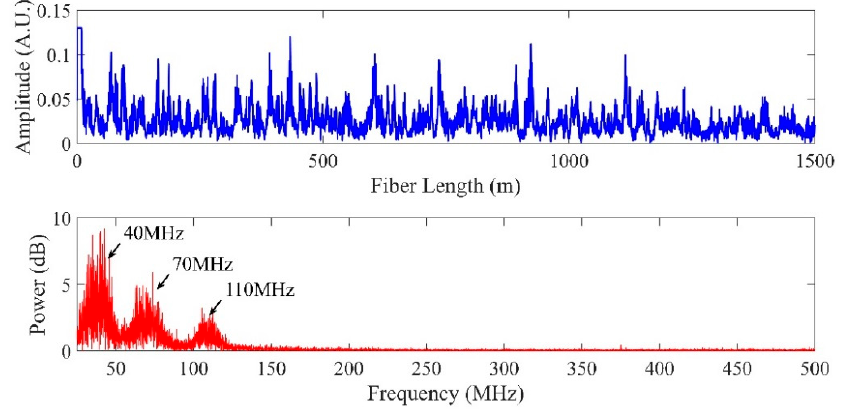
Figure 4. The time domain waveform and frequency spectrum of the output signal of the photodetector (PD).